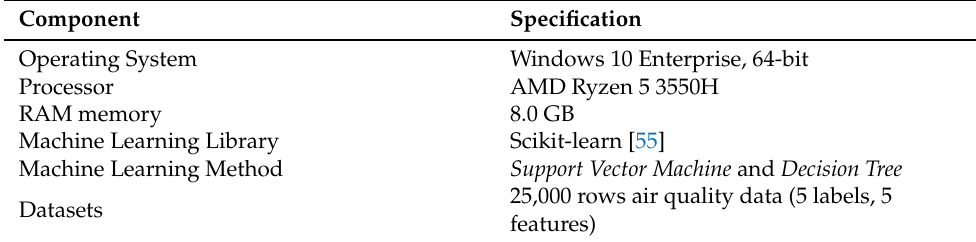
Table 4. Experiment setup for hyper parameter optimizations in air quality monitoring.